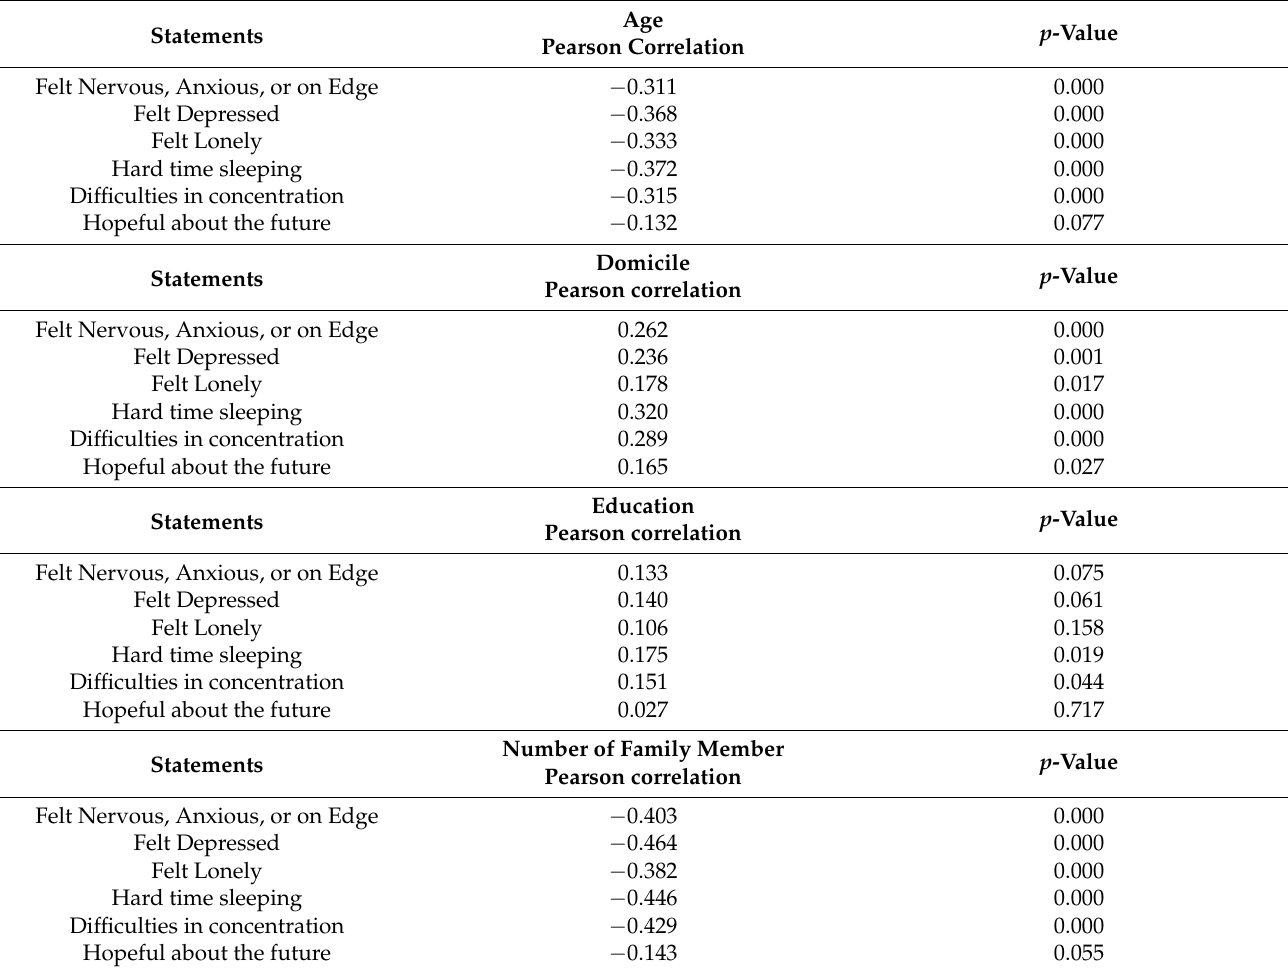
Table 10. Pearson’s correlation